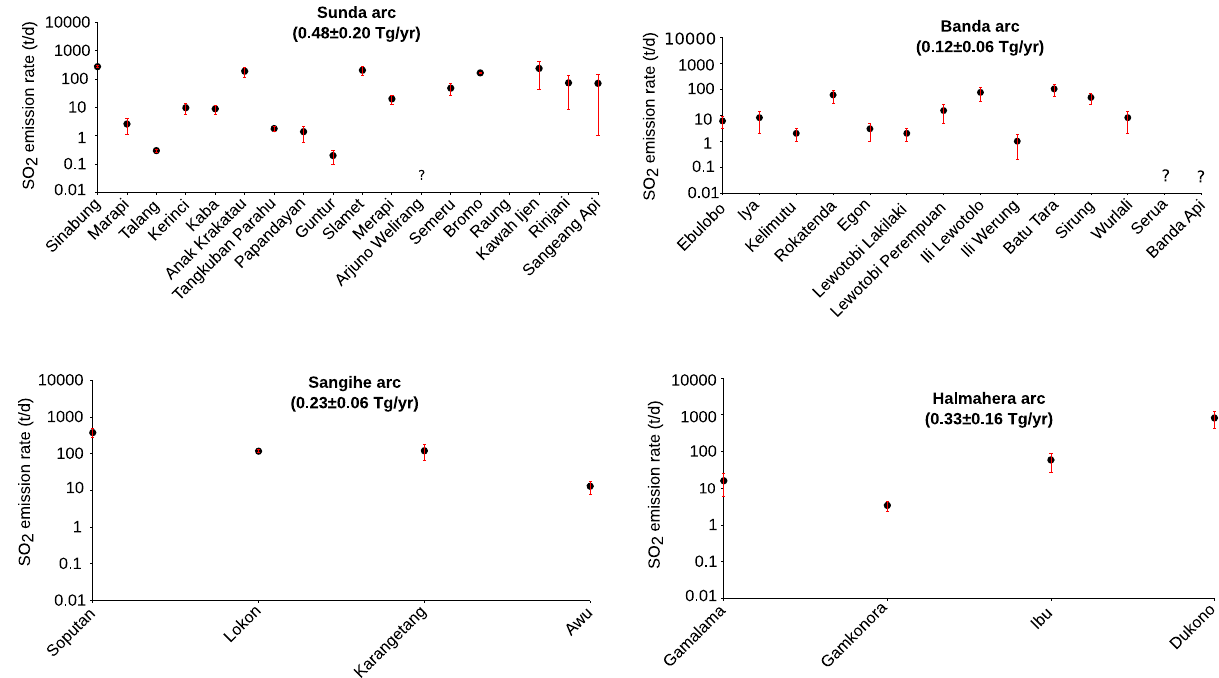
Fig. 2 The main volcanic degassing points of Indonesia. The SO 2 emission rates across the four volcanic arcs of Indonesia highlight the Sunda arc as the largest SO 2 contributor and Dukono is the strongest individual source. The question marks (?) denote the unmeasured sources and the error bars correspond to standard deviation.